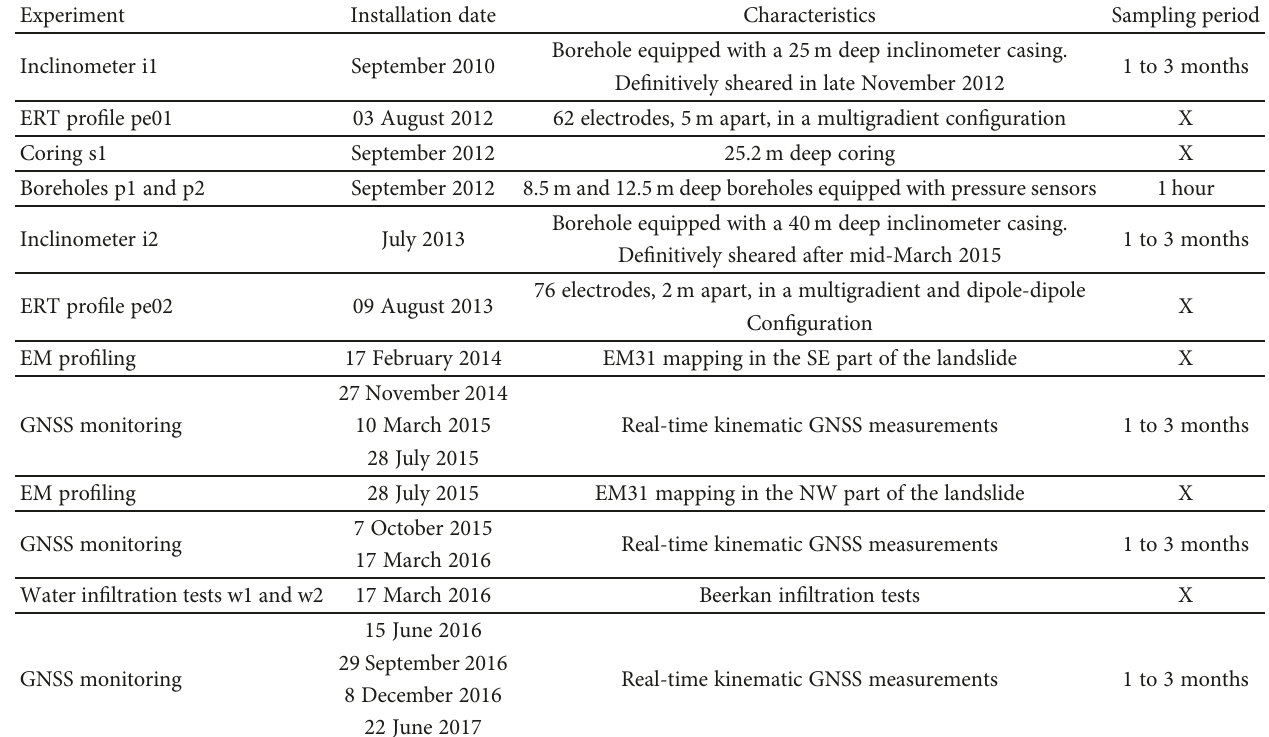
Table 1: Dates and characteristics of the experiments